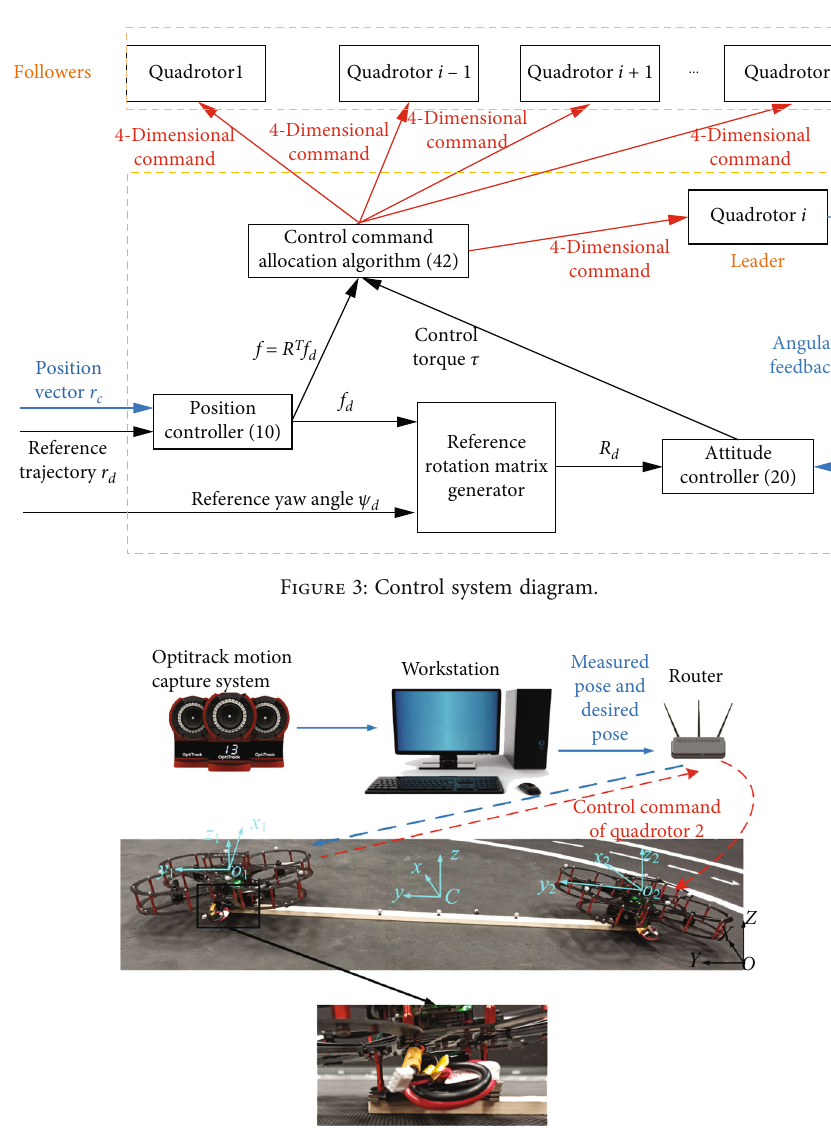
Figure 4: Experimental